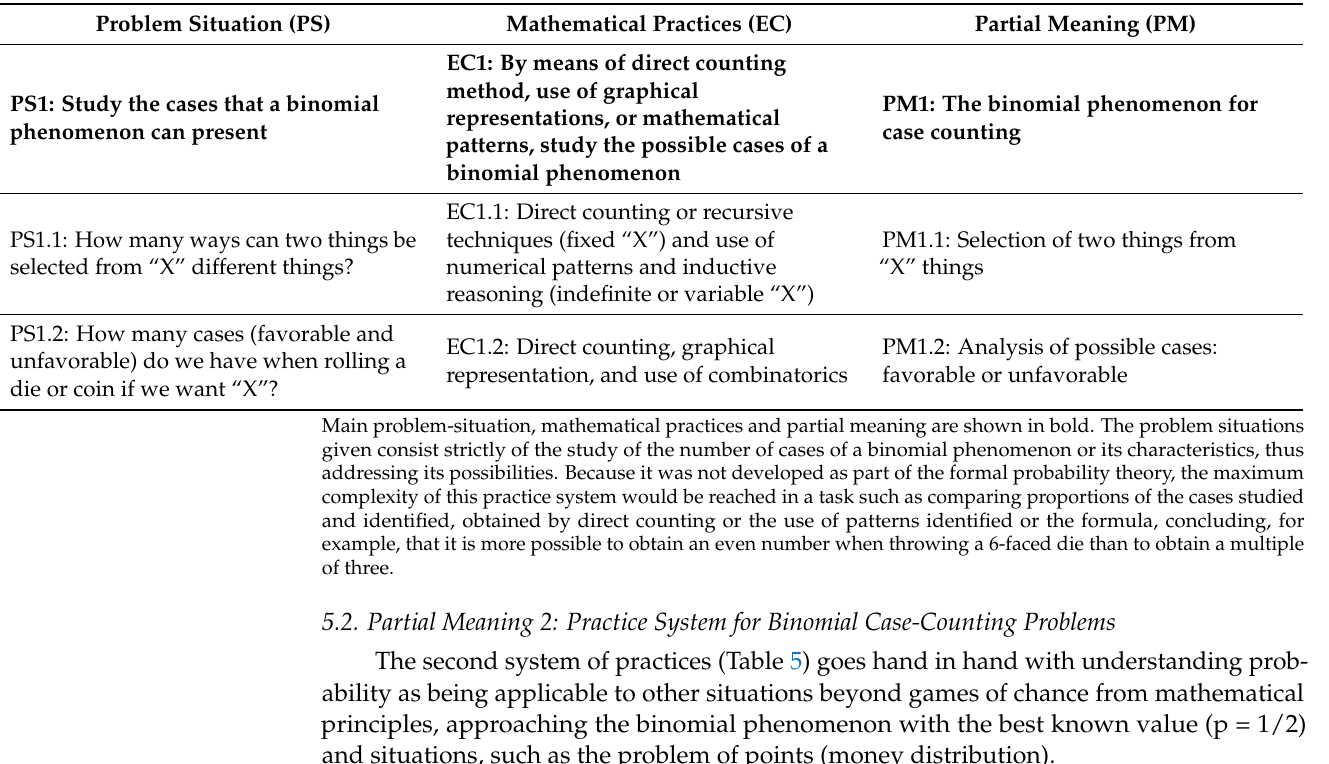
Table 4. Practice system for binomial problems involving case counting.